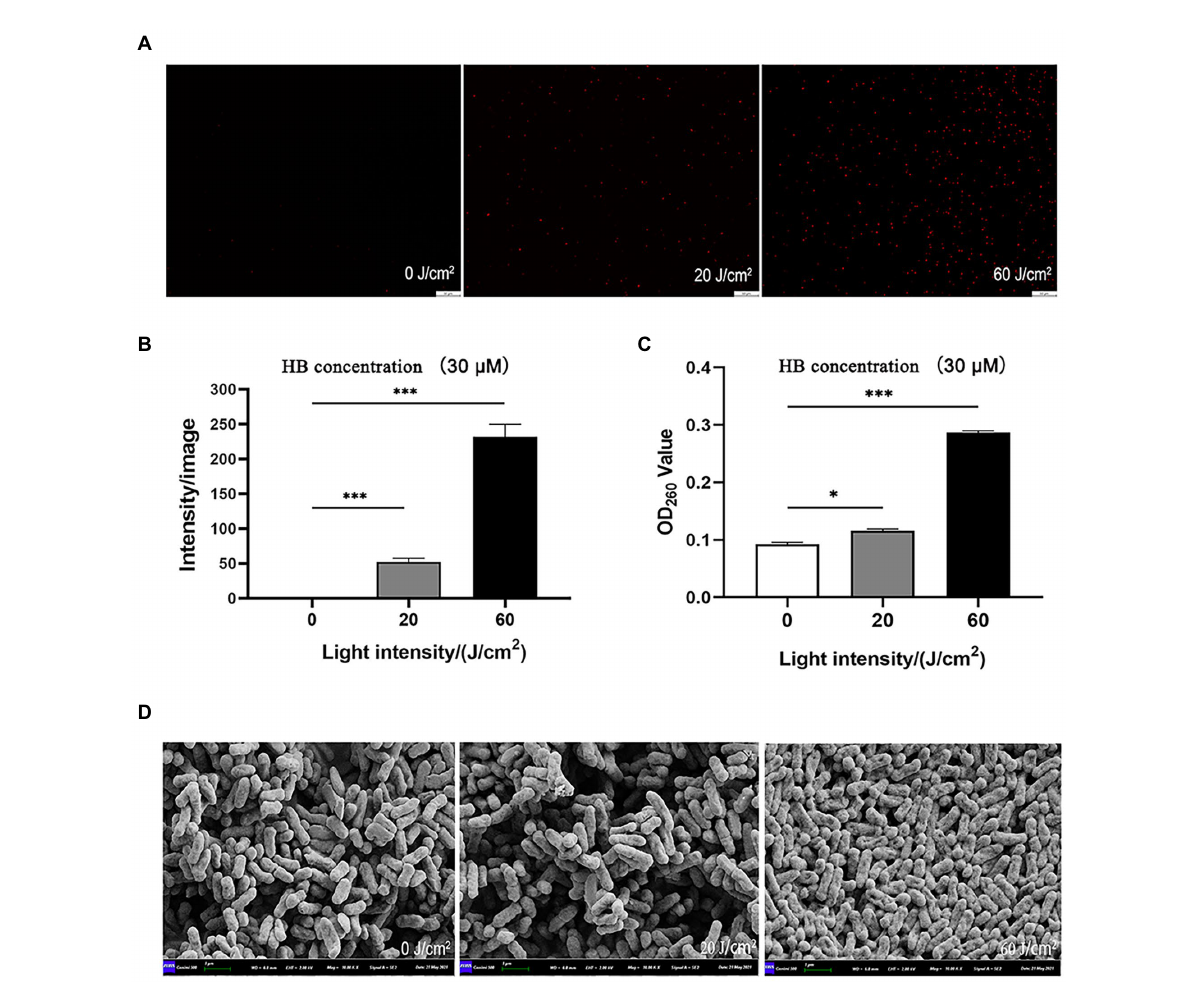
FIGURE 2 Effect of aPDI on the membrane integrity of C. sakazakii . The aPDI-treated bacterial cells were subjected to PI staining. Representative fluorescence microscopy images (A) , as well as their quantification (B) were shown in cells treated with 30 μ M HB photo-activated by various light doses. The scale bar represents 50 μ M. In addition, DNA leakage (C) was evaluated by measuring OD 260nm of extracellular substances, and cell surface structure was profiled by scanning electron microscopy (D) . The bar represents 1 μ m. Values are the mean ± SEM (standard error of mean) from 5~6 replicates. * p < 0.05, ** p < 0.01, *** p <